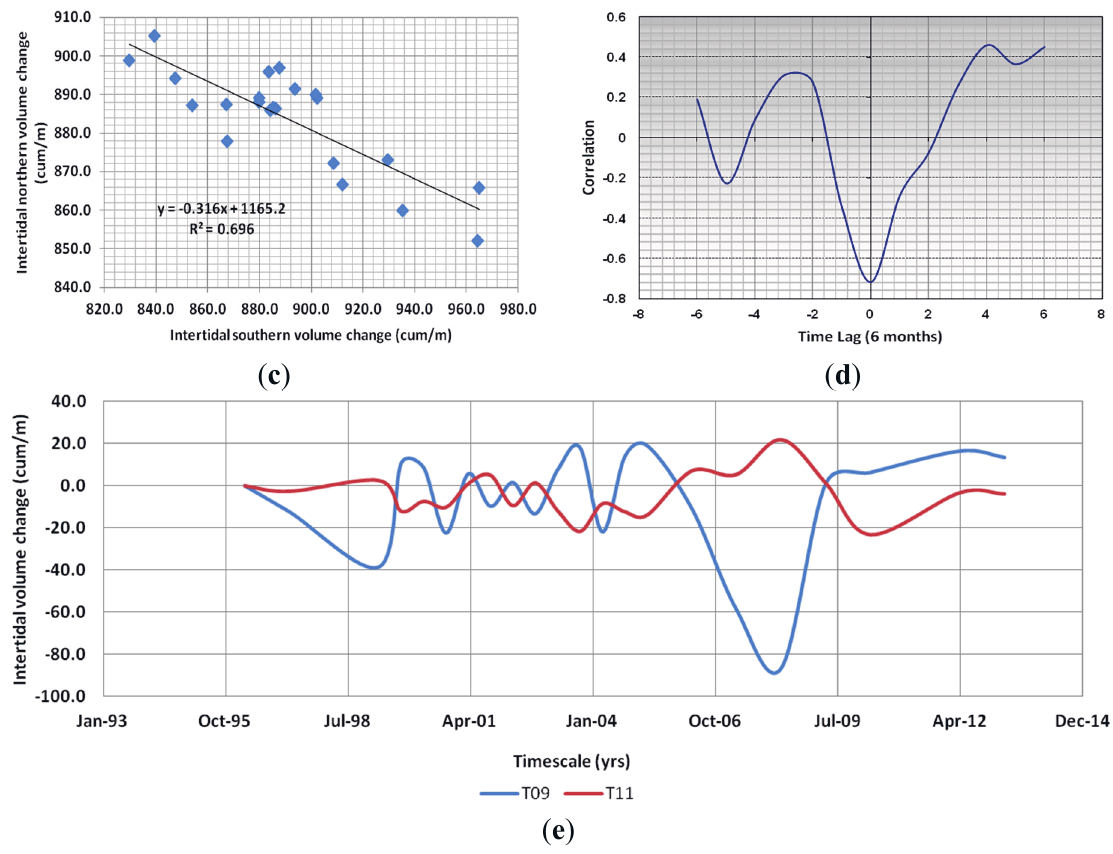
Figure 6. Analyses of transformed beach intertidal volume trends 1996–2013: ( a ) between south and north beach extremities; ( b ) between southern and central zones; ( c ) between northern and central zones; ( d ) cross-correlation results between south and north beach extremities; and ( e ) a graphical representation depicting temporal inter-survey volume